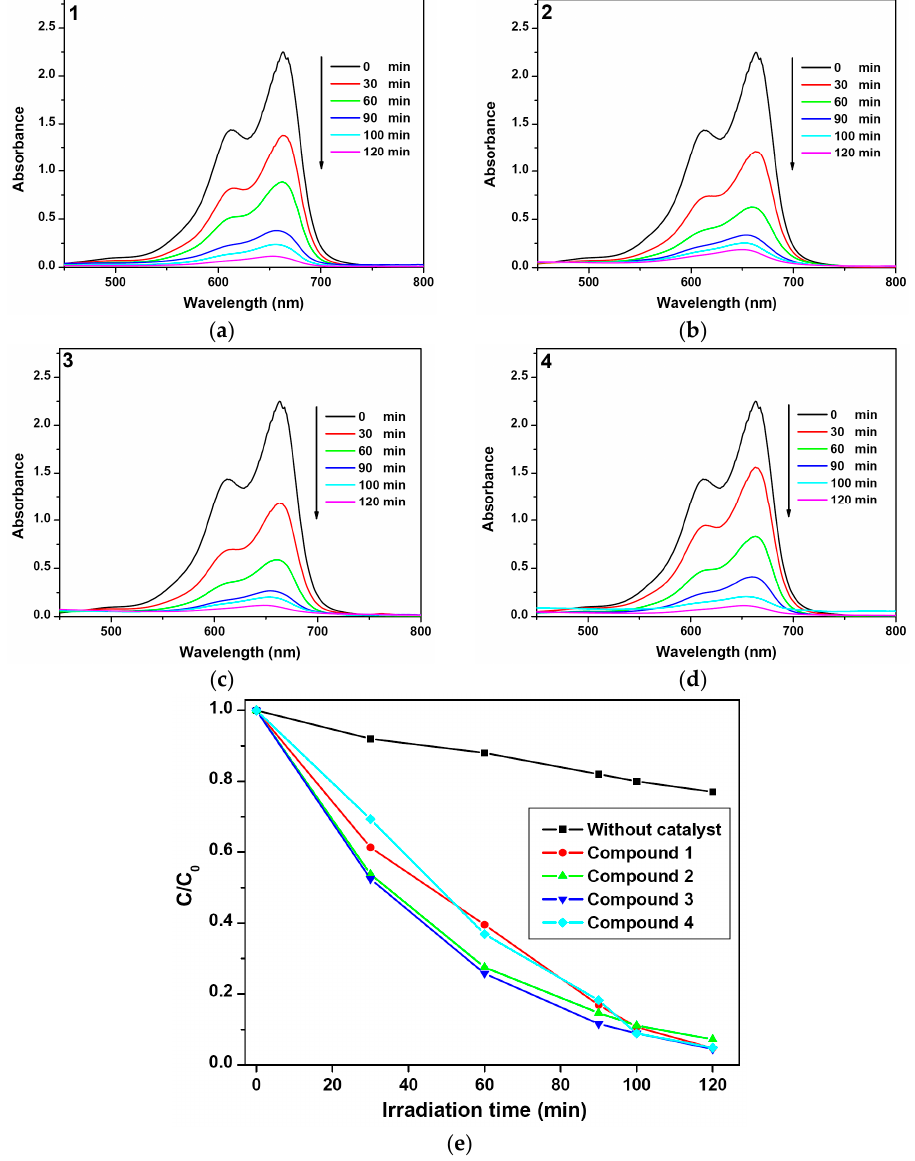
Figure 7. ( a – d ) Absorption spectra of the MB solution (4 × 10 − 5 mol·L − 1 , 50 mL) during the decomposition reaction under the Xe lamp irradiation with the presence of compounds 1 – 4 (20 mg); ( e ) Concentration changes of MB at different time intervals under Xe lamp irradiation with 1 – 4 as catalysts and without catalyst.